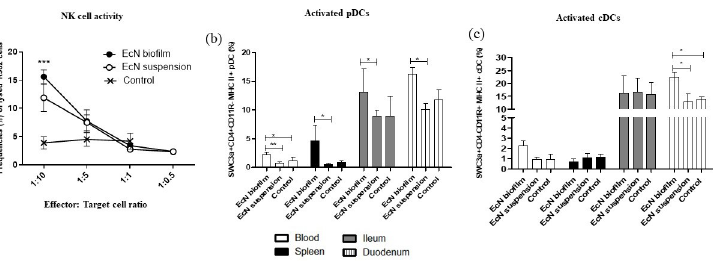
Fig 1. EcN biofilm enhanced NK cell activity in blood mononuclear cells (MNCs) and significantly increased the frequencies of activated pDCs in systemic and intestinal tissues and increased activated cDCs in blood and duodenum (significantly). (a) Blood MNCs and carboxyfluorescein diacetate succinimidyl ester (CFSE) stained K562 tumor cells were used as effector and target cells, respectively, and co-cultured at set ratios to assess the NK cytotoxic function, (EcN biofilm vs control group). The effector: target cell co-cultures were stained with 7-Aminoactinomycin D (7AAD) after 12 hours of incubation at 37˚C, and the frequencies of CFSE-7AAD double positive cells (lysed K562 target cells) were assessed by flow cytometry. Mean frequencies of activated (b) pDCs and (c) cDCs in systemic and intestinal tissues. Data represent means ± SEM. Significant differences ( � p < 0.05, �� p < 0.01, ��� p < 0.001) are indicated. Gnotobiotic pigs were transplanted with human infant fecal microbiota (HIFM) at 4 days of age, post-HIFM transplantation day (PTD) 0. Pigs were fed a deficient diet. Probiotic was given to the respective groups at PTD 11, followed by challenge with virulent human rotavirus (HRV) on PTD 13/post-challenge day (PCD) 0 and pigs were euthanized on PTD 27/PCD 14.